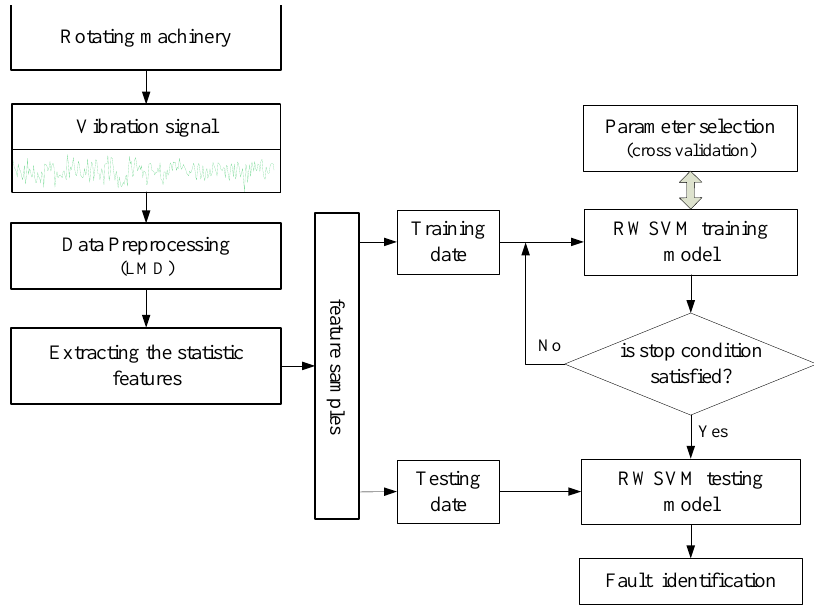
Figure 6. Architecture of the proposed fault diagnosis